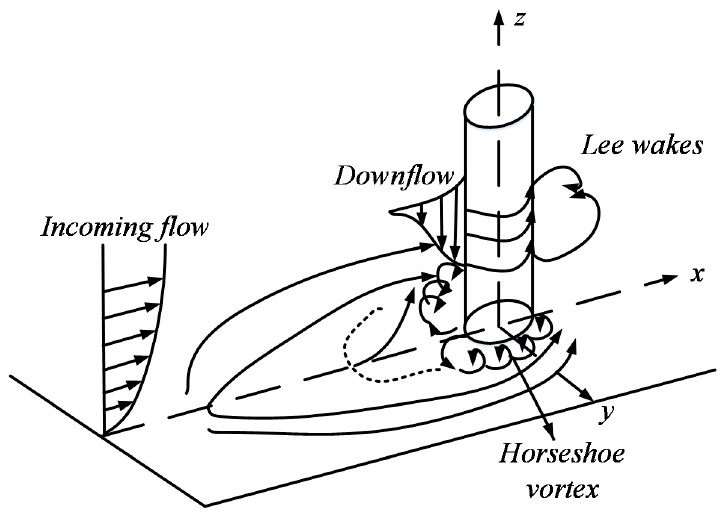
Figure 1. The flow structures around the cylinder.